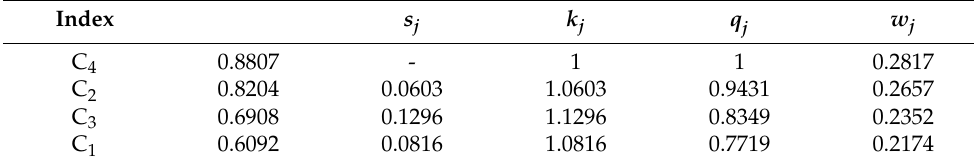
Table 5. Weight values obtained using the SWARA